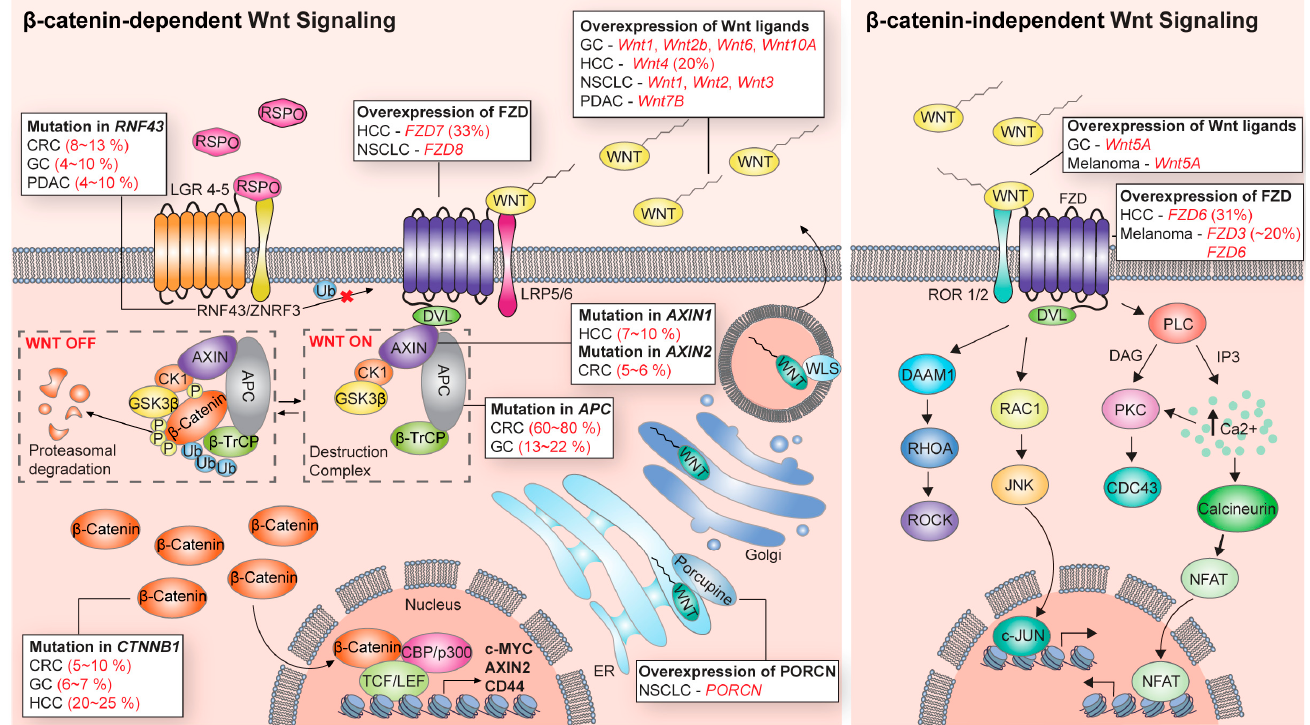
Figure 1. Wnt signaling and its alteration in various cancers. Signal transduction of β -catenin-de- pendent and independent Wnt signaling. The frequencies of genetic alteration of individual Wnt signaling modules in indicated cancers were summarized.